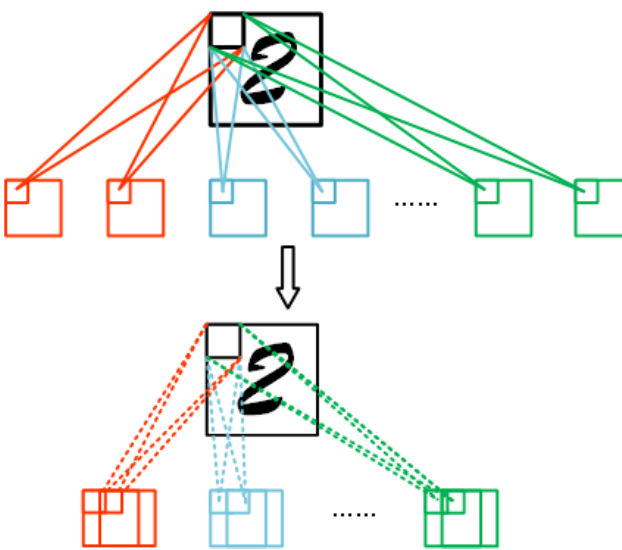
Figure 2. Agglomerating neurons in the convolutional